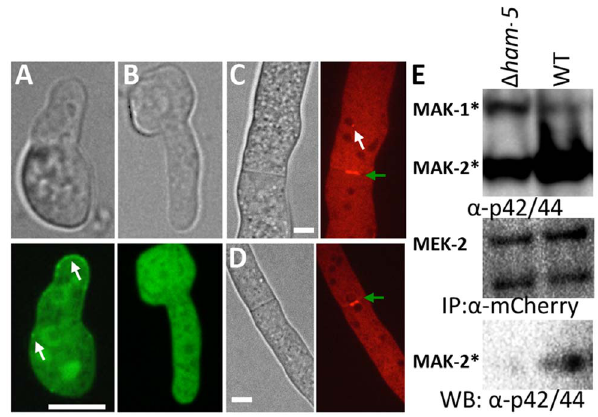
Figure 5. HAM-5 is required to localize MAK-2 and MEK-2 to puncta. (A) MAK-2-GFP in isolated WT germlings localizes to the nucleus, cytoplasm and to puncta (white arrows). (B) In the D ham-5 mutant, MAK-2-GFP localization is cytoplasmic and nuclear; no puncta are observed. Scale bar =10 m M. (C) In WT hyphae, MEK-2-mCherry localizes to the septum (green arrow) and also to cytoplasmic puncta (white arrow). Scale bar =10 m M. (D) In D ham-5 hyphae, septum localization of MEK-2-mCherry is observed (green arrow), but puncta are not. Scale bar =10 m M. (E) Co-immunoprecipitation experiments showing an interaction between MEK-2-mCherry and phosphorylated MAK-2 in WT ( mek-2-mCherry ) germlings, but a significant reduction in interaction between MAK-2 and MEK-2-mCherry in a D ham-5 ( mek-2- mCherry ) strain. Top panel is a Western blot of protein samples probed with anti-p42/44 antibodies (MAK-2, 40.8 kD, MAK-1, 46.7 kD; Figure S4E). Middle panel is anti-mCherry immunoprecipitated proteins probed with anti-mCherry antibodies (MEK-2-mCherry, 82.9 kD; Figure S4C, E). Bottom panel is anti-mCherry (MEK-2-mCherry) immunoprecip- itated proteins probed via Western blot with anti-p42/44 antibodies that recognize phosphorylated MAK-2.